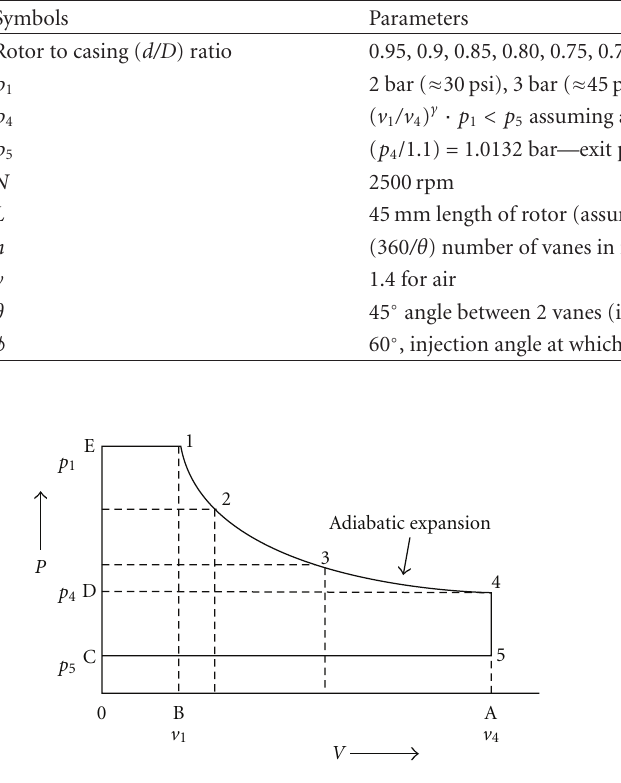
Table 1: Input parameters.